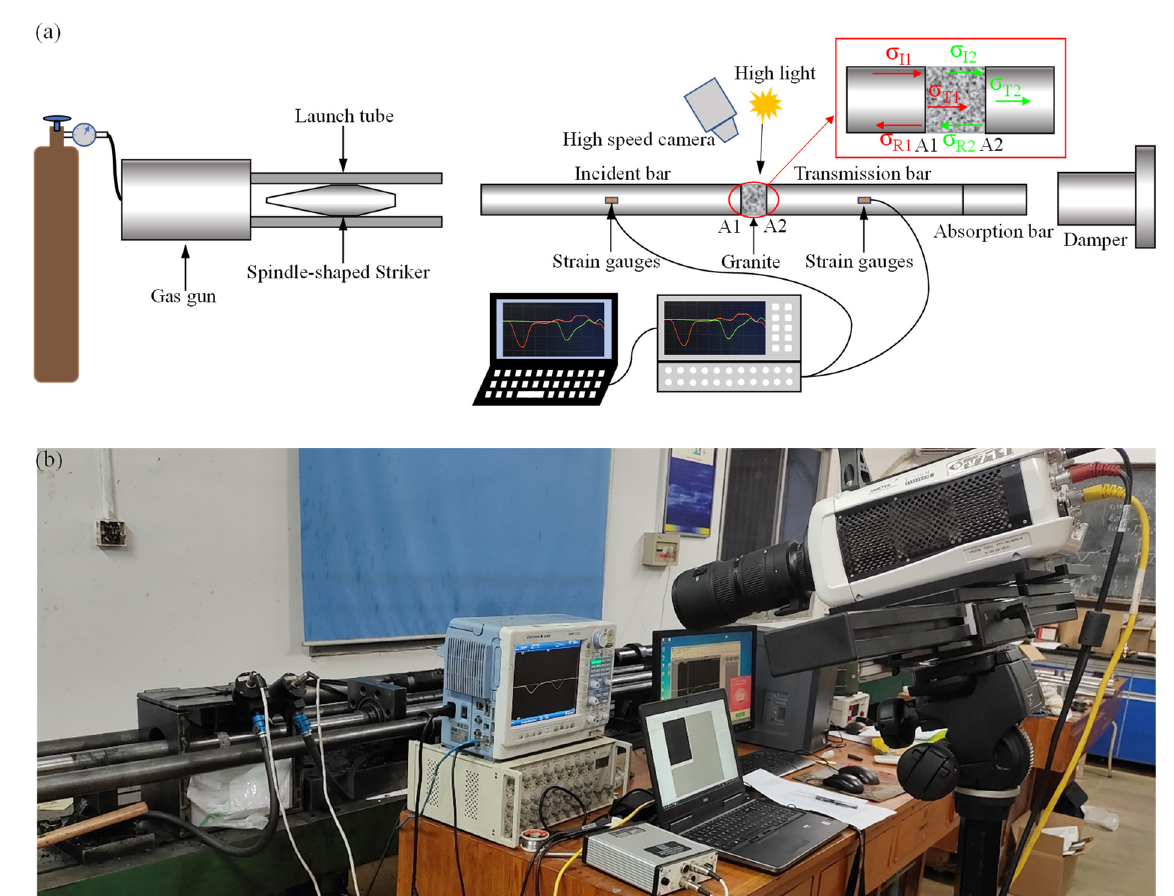
Figure 3. SHPB device. ( a ) Schematic diagram; ( b ) Scene photo.